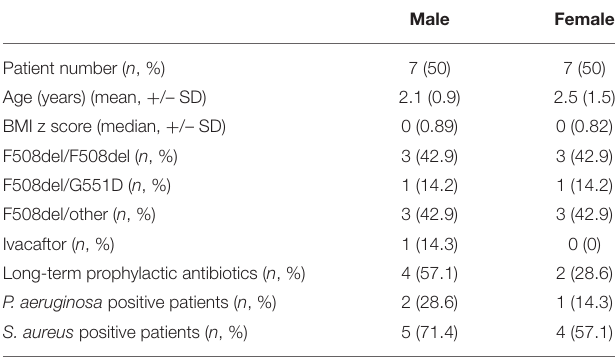
TABLE 1 | Patient demographics and clinical details at time of BAL